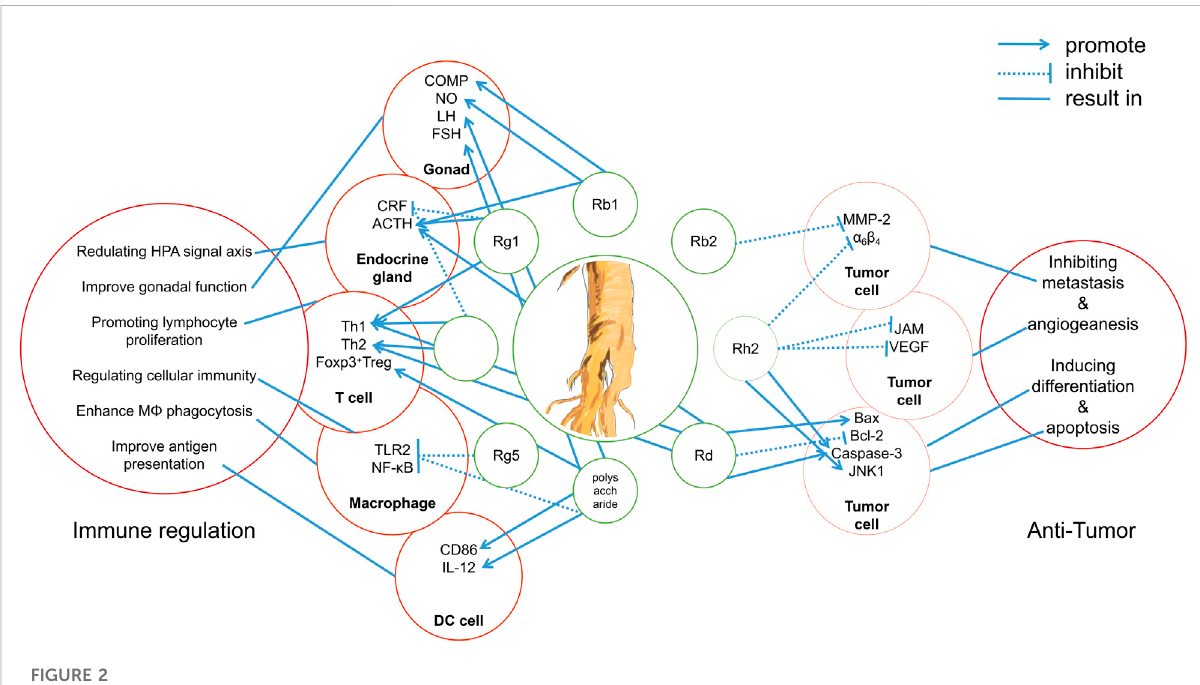
FIGURE 2 Integrated mechanisms of active components of